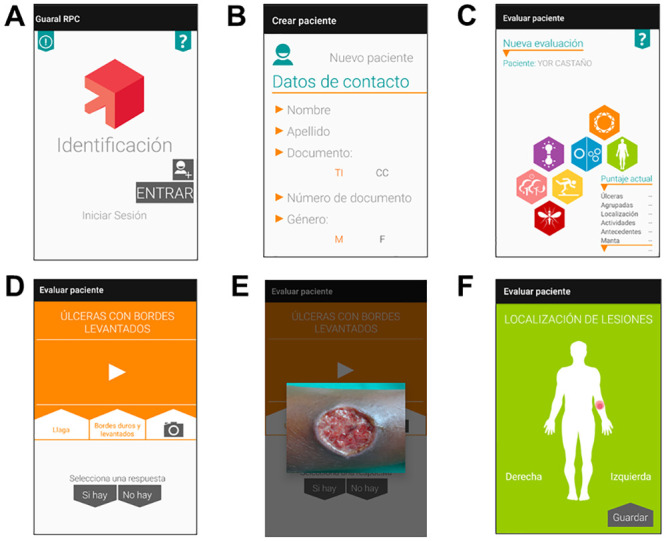
mHealth tool (app) for presumptive diagnosis of leishmaniasis.(A) Homepage requesting user’s name and ID. (B) Personal information for each patient. (C) Main screen with six icons representing the six items of the prediction rule. (D) Menu for Item 1, lesions. (E) Image for user guidance, showing a typical CL lesion. (F) Interface for item 3, allowing the user to select the exact lesion site(s).